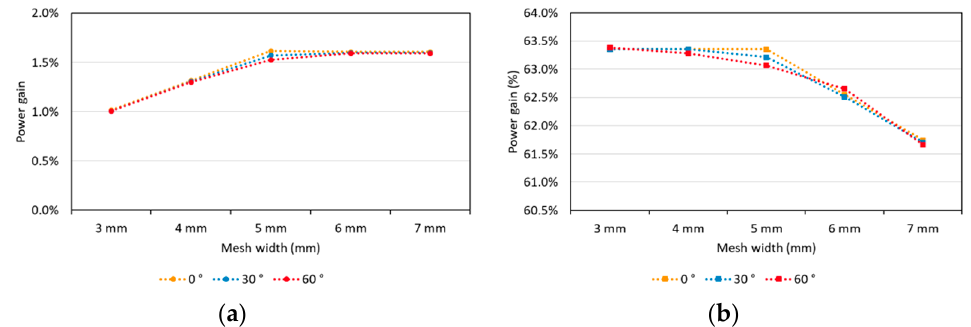
Figure 13. Power gain depending on white backsheet width: ( a ) power gain due to irradiance from white backsheet; ( b )